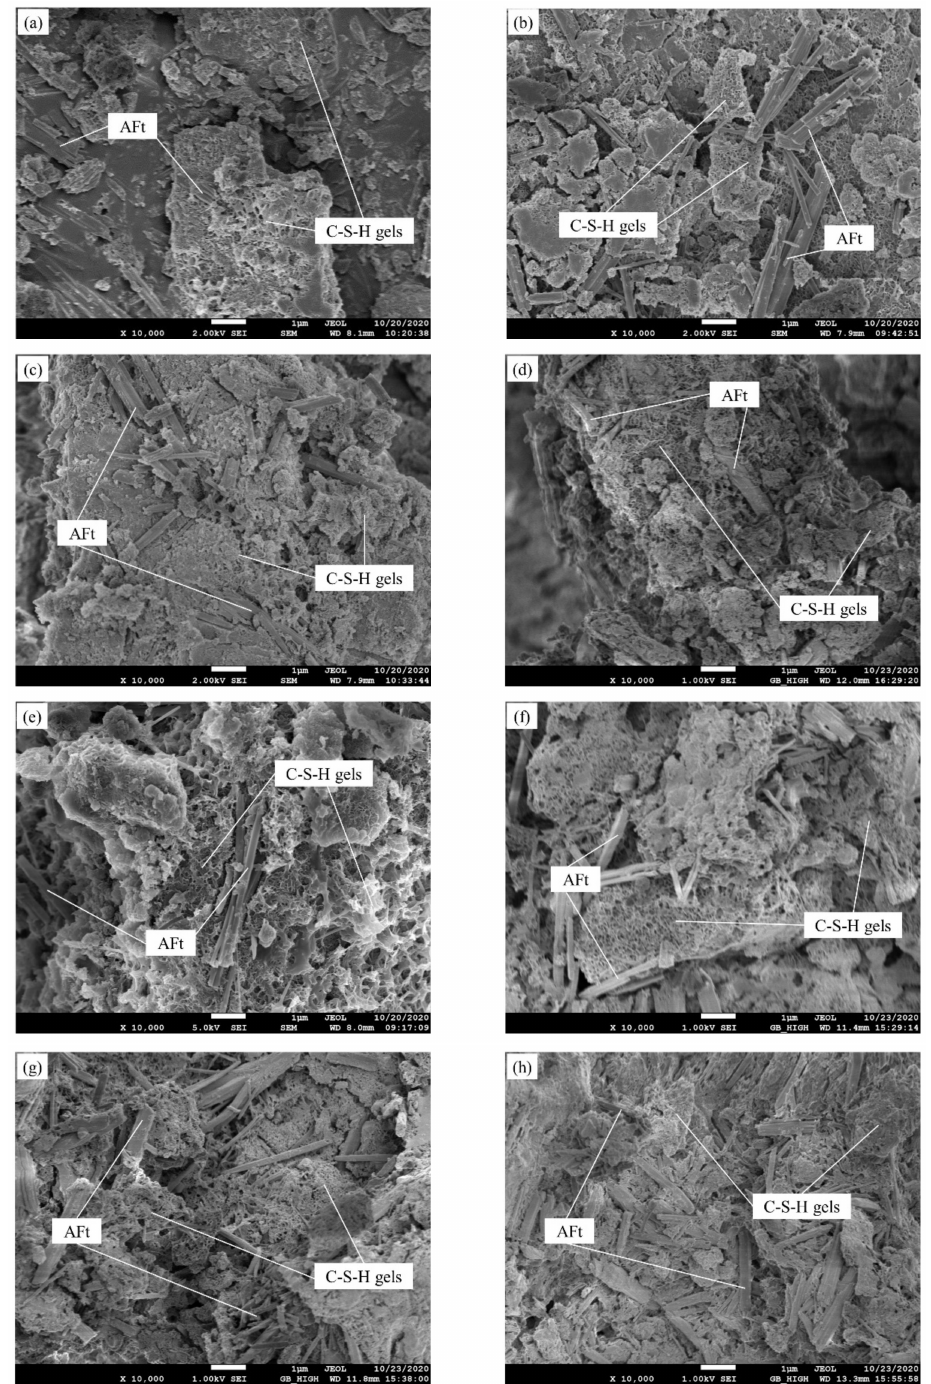
Figure 9. SEM images of pastes: ( a ) SG2, 3 d; ( b ) SG2, 7 d; ( c ) SG2, 14 d; ( d ) SG2, 21 d; ( e ) SG1, 28 d; ( f ) SG2, 28 d; ( g ) SG3, 28 d; ( h ) SG4, 28